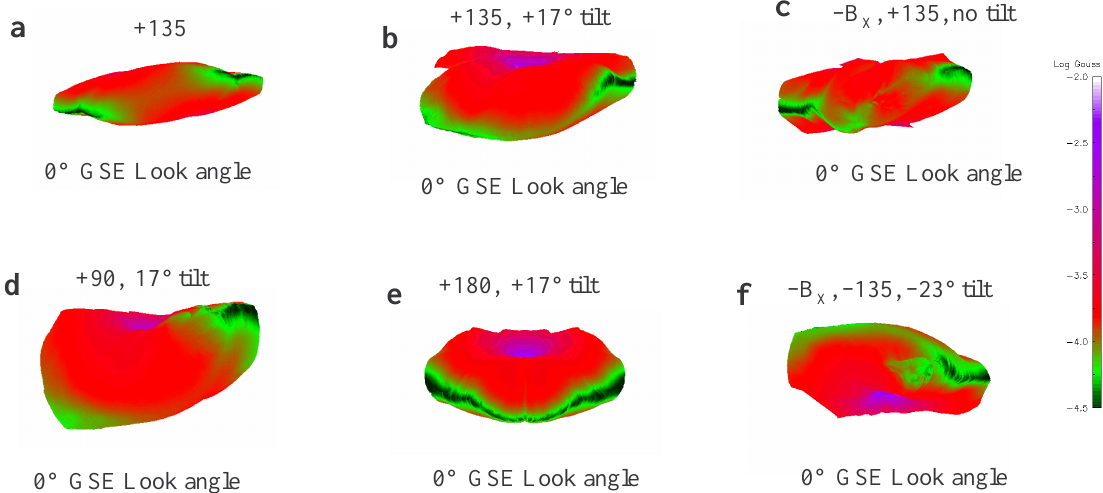
Fig. 16. Simulation results showing the magnetopause surface generated by the last closed field lines and colored with the log of the magnetic field magnitude. The low magnetic field values indicated by green or black serve as a proxy for possible merging locations. Various IMF clock angles, dipole tilts, and B X combinations are displayed in the six panels and discussed in the